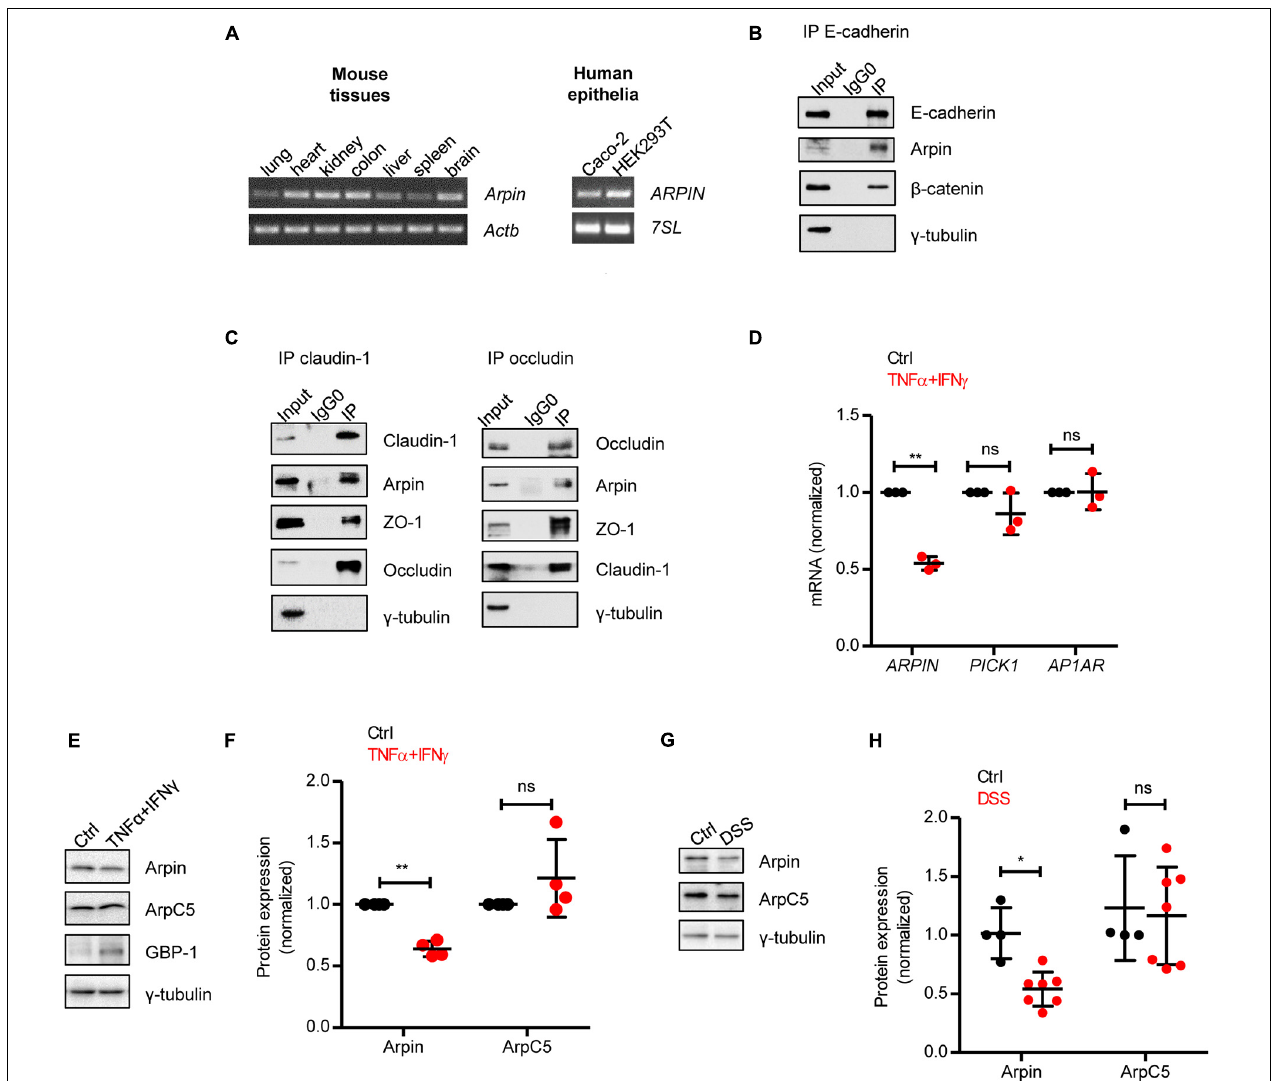
FIGURE 1 | Arpin is downregulated under inflammatory conditions. (A) RT-PCR for Arpin and Actb using cDNA derived from the indicated mouse tissues (left) and ARPIN and 7SL as housekeeping gene using cDNA derived from the indicated human cell lines (right); n = 3. (B) Western blot of E-cadherin immunoprecipitates. β -catenin was probed as a positive control of interaction and γ -tubulin as a negative control; n = 3. Input = whole cell lysate; IgG0 = IP using IgG as control, IP = IP using specific antibodies. (C) Western blots of claudin-1 and occludin immunoprecipitates. ZO-1 was probed as a positive control and γ -tubulin as a negative control, n = 3. (D) Quantitative real-time RT-PCR for the Arp2/3 inhibitors ARPIN , PICK1 , and AP1AR using cDNA from Caco-2 colon epithelial cells treated or not with tumor necrosis factor (TNF) α /interferon (IFN) γ ( n = 3; two-tailed t -test). Data are shown as relative expression normalized to the housekeeping gene 7SL . (E) Western blot for arpin and the Arp2/3 subunit ArpC5 in Caco-2 cells treated or not with TNF α /IFN γ . Guanylate-binding protein-1 (GBP-1) was used as an inflammation positive control. (F) Densitometric analysis of panel (E) ( n = 4; two-tailed t -test). (G) Western blot for arpin and ArpC5 in colons from control and dextran sulphate sodium (DSS)-treated mice. (H) Densitometric analysis of panel G (nCtrl = 4, nDSS = 7; two-tailed t -test followed by Mann–Whitney test). ns, non-significant; * p < 0.05; ** p <